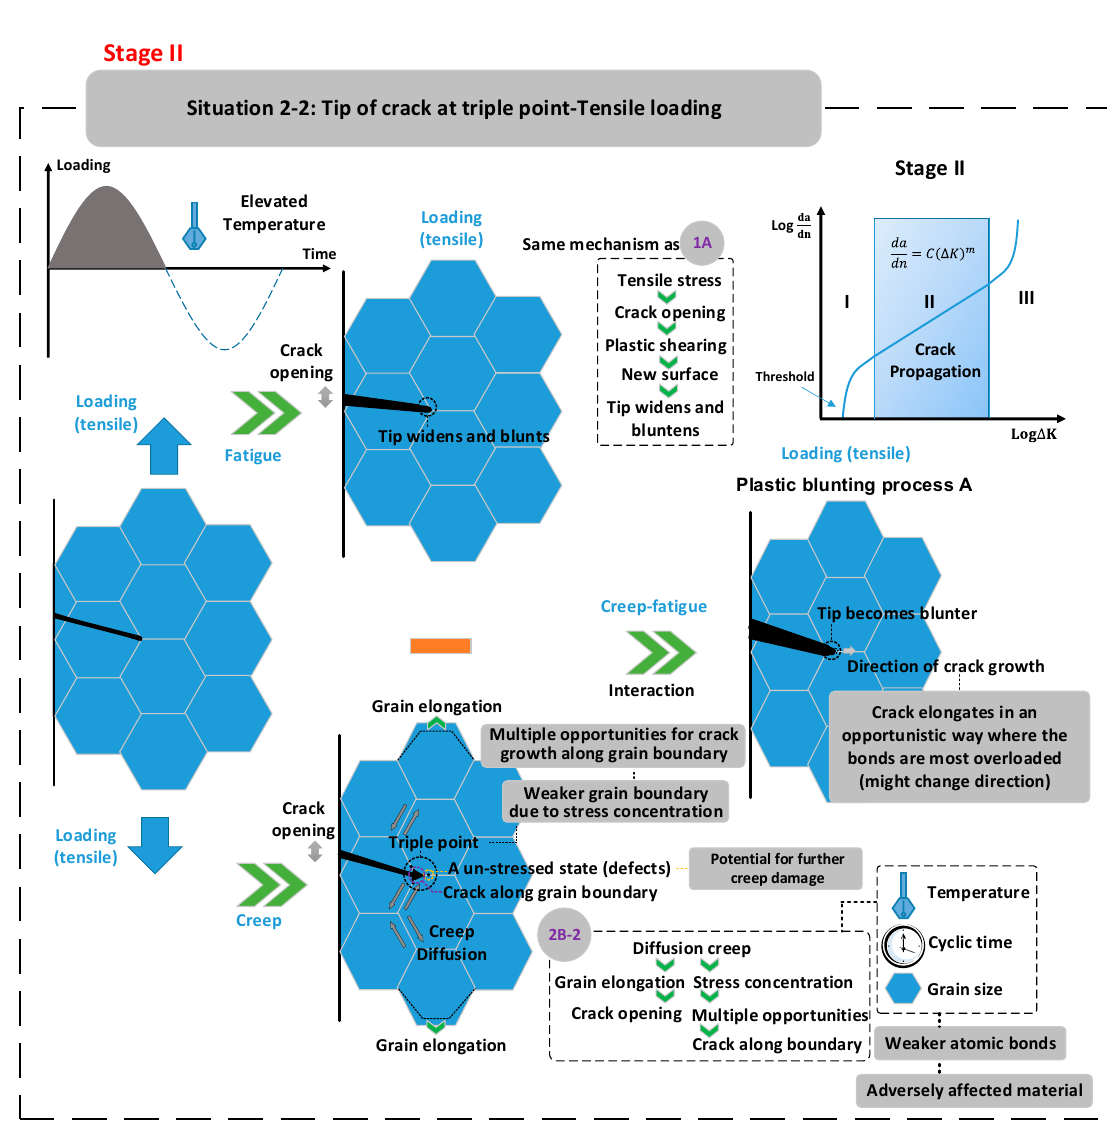
Figure 14. Crack tip at triple point—Tensile loading.